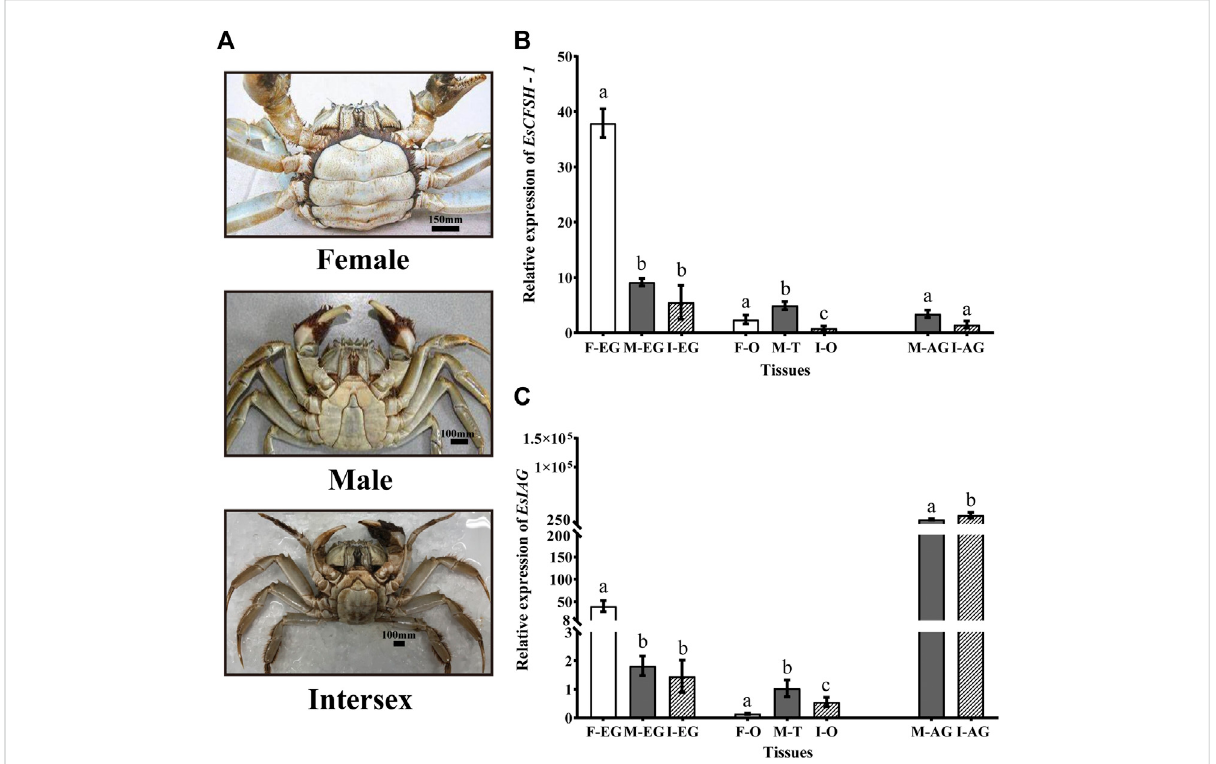
FIGURE 5 The distribution analysis of EsCFSH-1 and EsIAG in the normal and intersex mitten crabs (A) The abdominal morphology of intersex crab was betweennormalfemale(round)andmale(sharp)crabs (B) Thecomparativeexpressionpatternof EsCFSH-1 betweenthenormalandintersexmitten crabs (C) Expression level of EsIAG in the normal and intersex mitten crabs. F-EG, eyestalk ganglion of females; M-EG, eyestalk ganglion of males; I-EG, eyestalk ganglion of intersexes; F-O, ovary of females; M-T, testis of males; I-O, ovary of intersexes; M-AG, androgenic gland of males; I-AG, androgenic gland of intersexes. The data were presented as means ± SEM of eight separate individuals ( n = 8). Statistical signi fi cance was accepted at p < 0.05 and shown in different lower-case